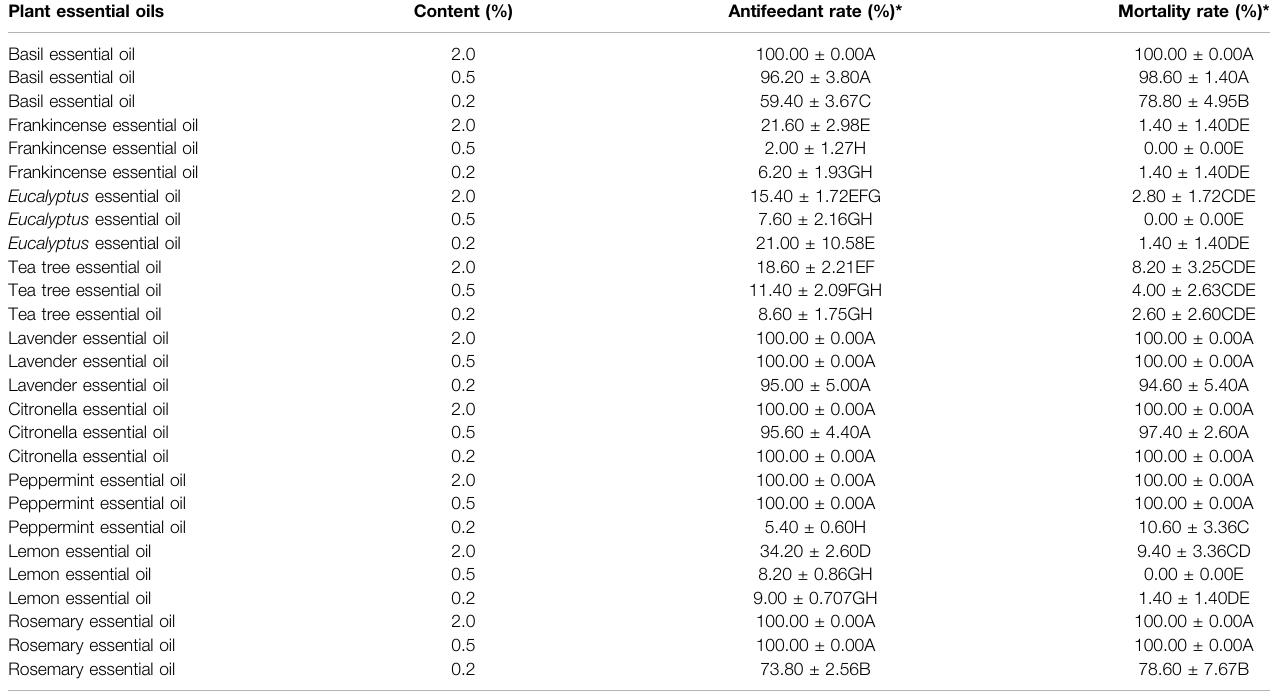
*Different capital letters in the same column in the table indicate a signi fi cant difference at p < 0.05.